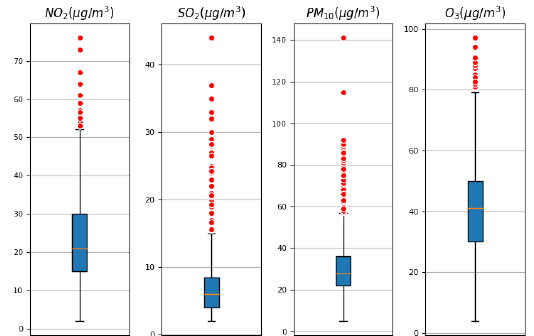
Figure 2. Results of the first phase of the NO 2 , SO 2 , PM 10 and O 3 analysis. Box plot representation of the air quality data in Gijón from 2014 to 2021. The orange line represents the mean, while the upper limit of the box is the third quartile, and the lower one corresponds to the first quartile. The red dots seen on the chart represent outlying